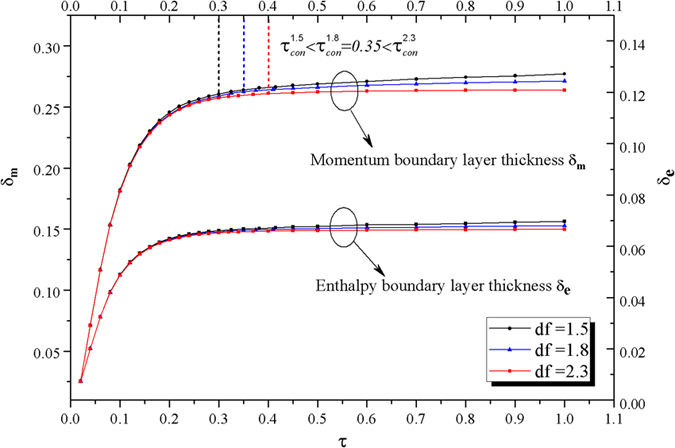
The growth of boundary layers thickness.Momentum and enthalpy boundary layers versus demensionless time for various fractal dimensions, and the numerical results demonstrate the time for fully developed convection with three different fractal dimensions that ,  and .